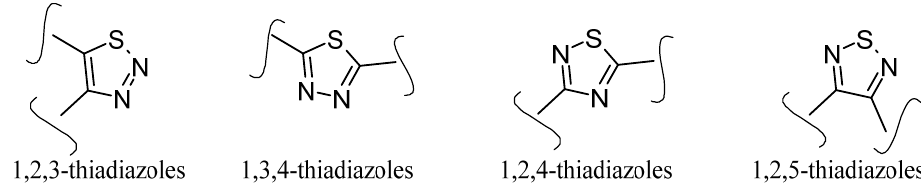
Figure 10. Structures of di ff erent isomeric forms of thiadiazole ring.